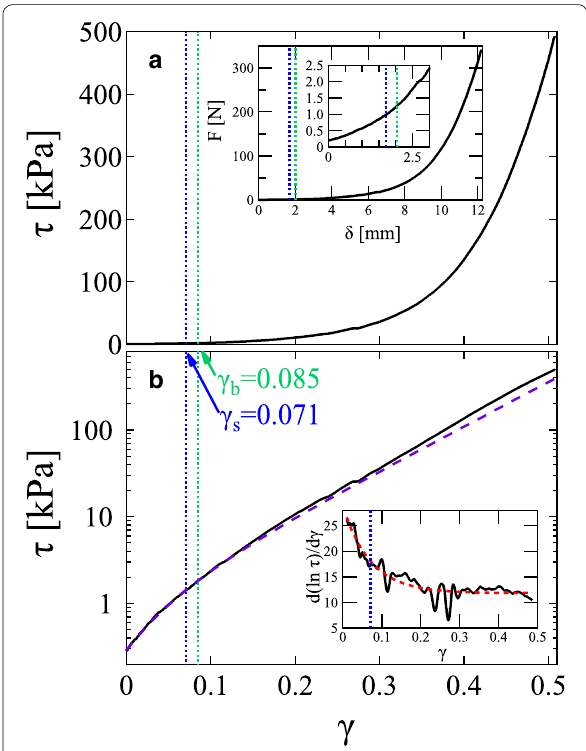
Fig. 4 Raw data from an example compression test. Parameters were C t = 30% , C s = 10% , and grain size d t = 32 – 63 µ m . a Linear plot of the stress–strain curve and b semi-log plot of the same data. The inset of a shows the raw compression force data. The inset of b shows the slope of ln τ as a function of strain γ . Purple dashed curve indicates the model of Eq. (11). Blue and green dotted lines are the levels of γ b and γ s obtained by fitting,